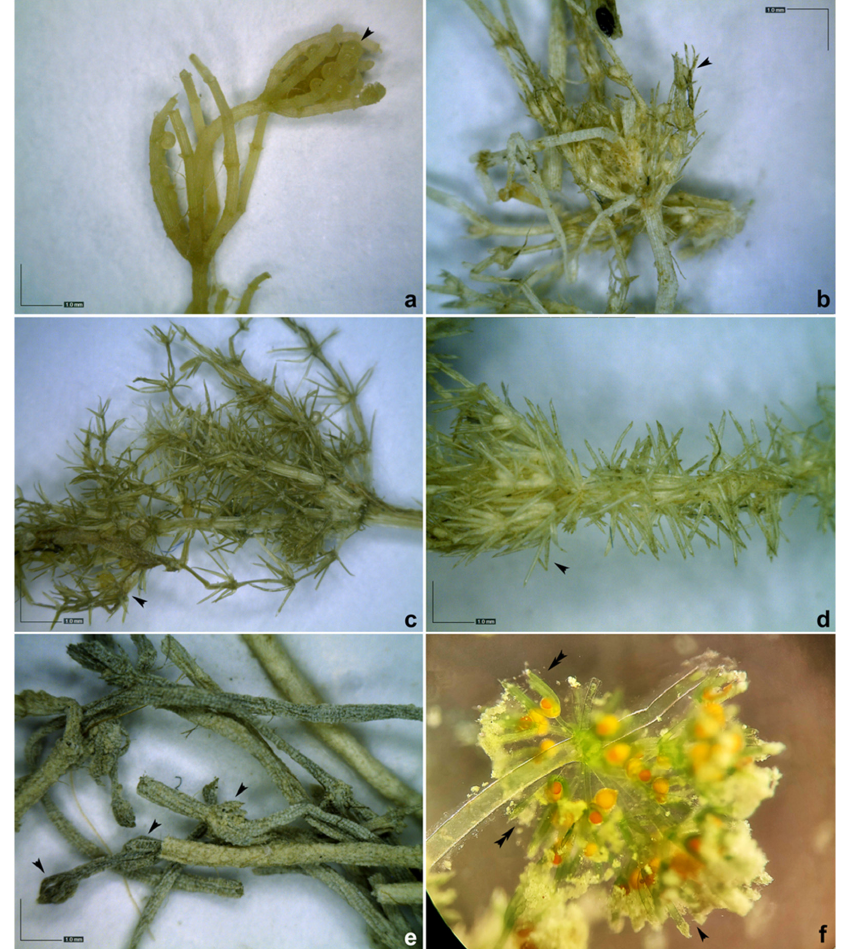
Figure A2. Chara aspera ( a , b ), C. canescens ( c , d ), C. kirghisorum ( e ), Nitella hyalina ( f ): ( a )—upper part of male plant of C. aspera var. subinermis from Lake Alakol, arrowheads—antheridia, ( b )—branchlet whorl of female plant from Lake Alakol, arrowhead—oogonium, ( c , d )—female plants from Lake Sorbulak: ( c )—whorl of branchlets, arrowhead—oogonium, ( d )—base of branchlets with well-developed posterior bract cell (arrowhead) and densely spiny stem, ( e )—parts of plants with typical short branchlets (arrowheads) from a pond at Kaskelen River, ( f )—whorl of heteromorphic branchlets, main (arrowhead) and accessory (double arrowheads) of plant from the Canal Bakanas, mucilage embedding most part of branchlets and stem and calcite crystals at its surface are visible. Scale: 1 mm. Photos ( a – e ) by S.S. Barinova, ( f )—by G. Jumakhanova. 3. Chara canescens Loiseleur Description: The plants are dioecious (only female ones) with haplostichous stem cortex, appearing spiny because of clustered well developed acute spine cells, acuminate stipulodes in 2 well developed rows, verticillate bract cells (Figure A2c,d).